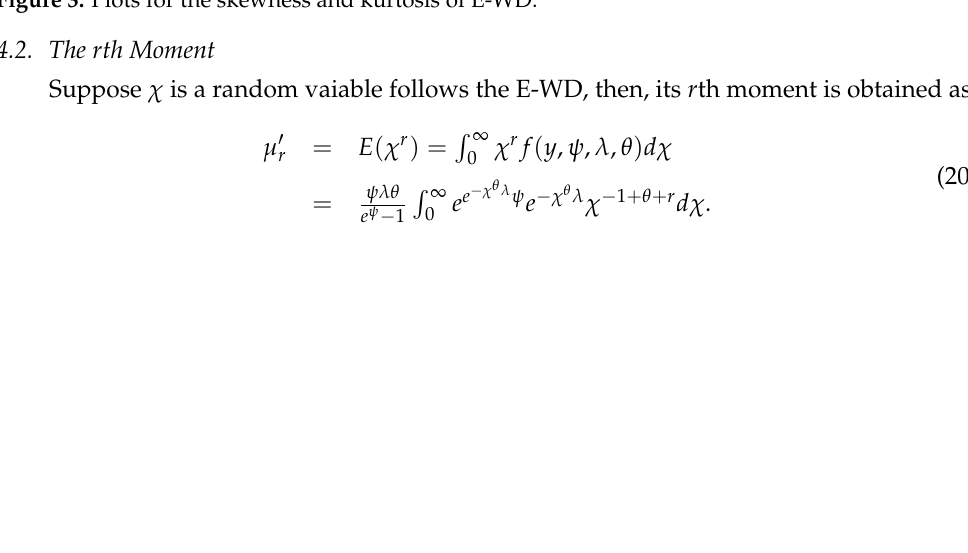
Figure 3. Plots for the skewness and kurtosis of